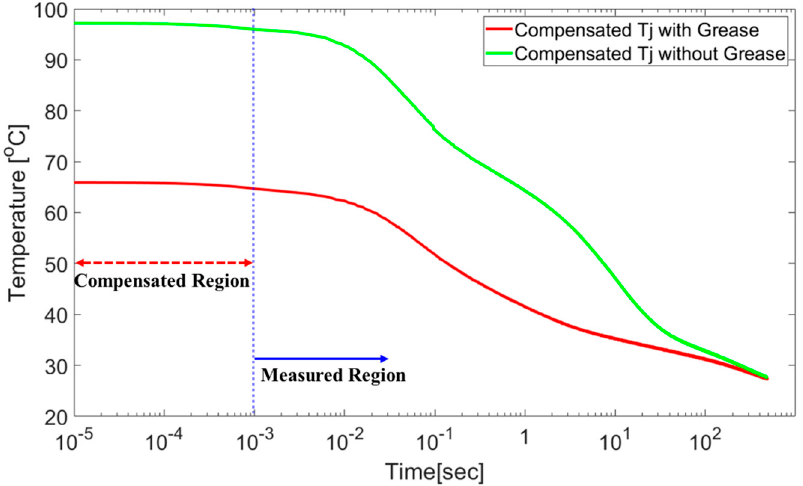
Figure 6. Compensated temperature profile, obtained by multi-physics simulation.